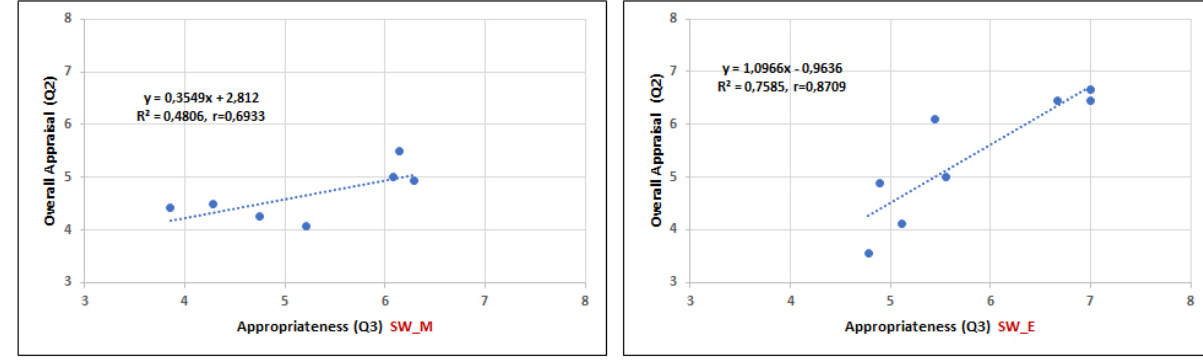
Figure 10: Overall appraisal (Q2) as a function of appropriateness (Q3) during the morning (SW_M) and evening (SW_E) soundwalks Table 4: Overall sound quality (Q2) and appropriateness (Q3) correlation vs noise